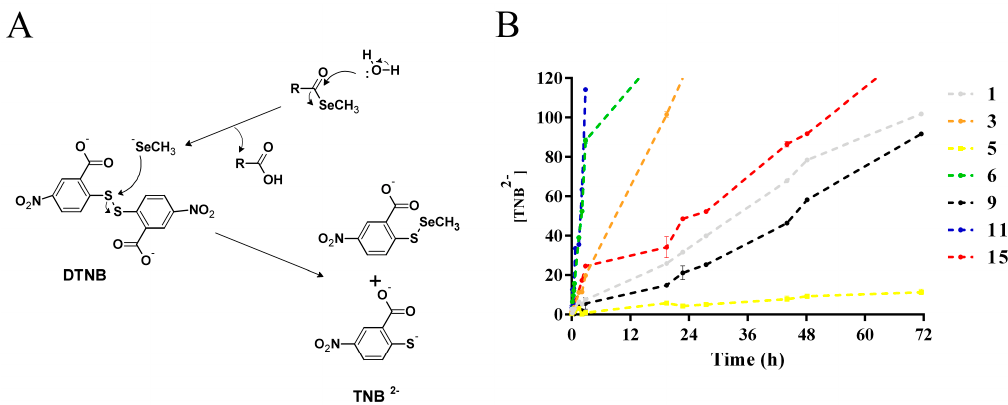
Figure 2. CH 3 SeH release rates are dependent on the chemical features of the molecule. Released CH 3 SeH was quantified through reaction with Ellman’s reagent (DTNB). ( A ) Proposed reaction between CH 3 SeH and DTNB; ( B ) Quantification of TNB 2 − at different times. The compounds were tested at 100 μ M in 200 μ L of 100 mM phosphate buffer (1 mM EDTA, pH = 8). DTNB concentration was also 100 μ M. Absorbance was followed at 412 nm over 72 h. A cysteine standard curve (7.5–150 μ M) was used to calculate the concentration of TNB 2 − over time. Compounds showing less than 15% hydrolysis at 72 h are not included, except for compound 5 as example. Error bars indicate SD of triplicates.